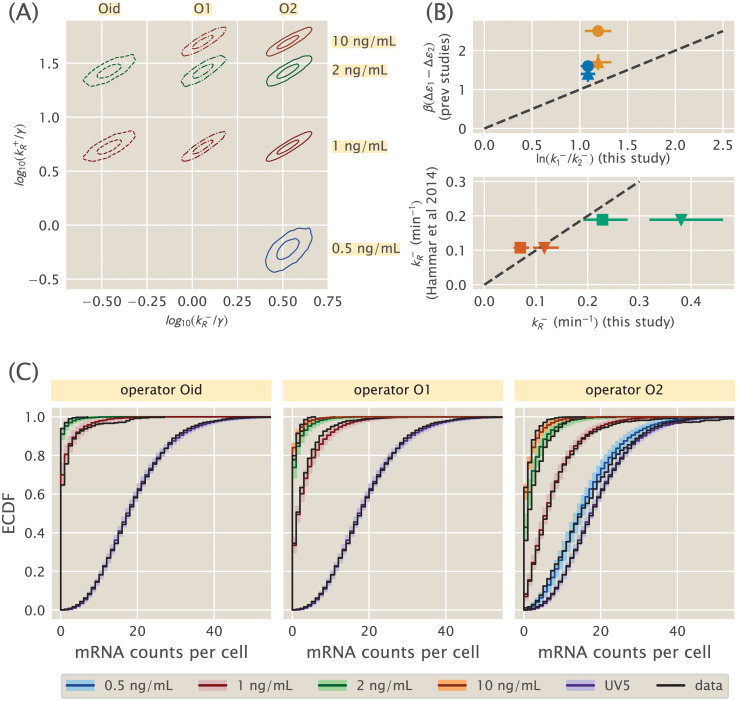
Simple repression parameter inference and comparison.(A) Contours which enclose 50% and 95% of the posterior probability mass are shown for each of several 2D slices of the 9D posterior distribution. The model assumes one unbinding rate for each operator (Oid, O1, O2) and one binding rate for each aTc induction concentration (corresponding to an unknown mean repressor copy number). (B, upper) Ratios of our inferred unbinding rates are compared with operator binding energy differences measured by Garcia and Phillips [41] (triangles) and Razo-Mejia et. al. [43] (circles). Blue glyphs compare O2-O1, while orange compare O1-Oid. Points with perfect agreement would lie on the dotted line. (B, lower) Unbinding rates for O1 (green) and Oid (red) inferred in this work are compared with single-molecule measurements from Hammar et. al. [55]. We plot the comparison assuming illustrative mRNA lifetimes of γ−1 = 3 min (triangles) or γ−1 = 5 min (squares). Dotted line is as in upper panel. (C) Theory-experiment comparison are shown for each of the datasets used in the inference of the model in (A). Observed single-molecule mRNA counts data from [33] are plotted as black lines. The median of the randomly generated samples for each condition is plotted as a dark colored line. Lighter colored bands enclose 95% of all samples for a given operator/repressor copy number pair. The unregulated promoter, lacUV5, is shown with each as a reference.